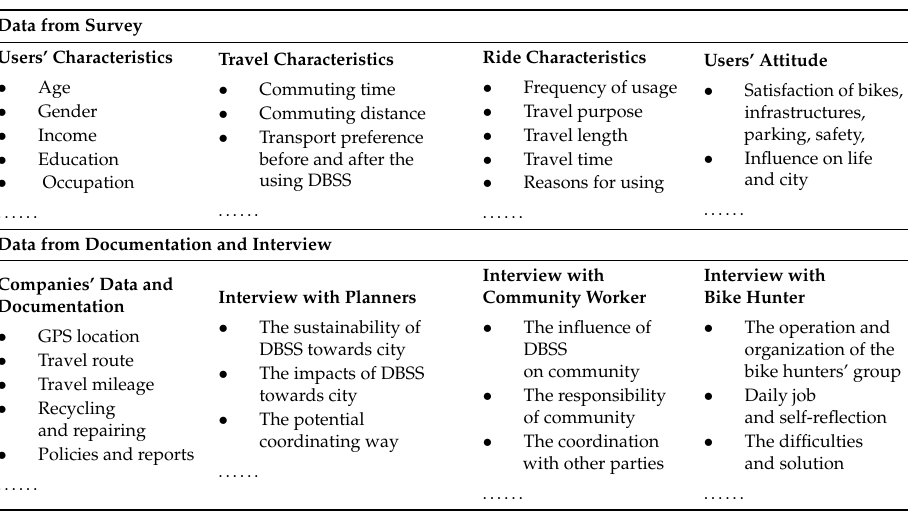
Table 2. Targeted data and collecting